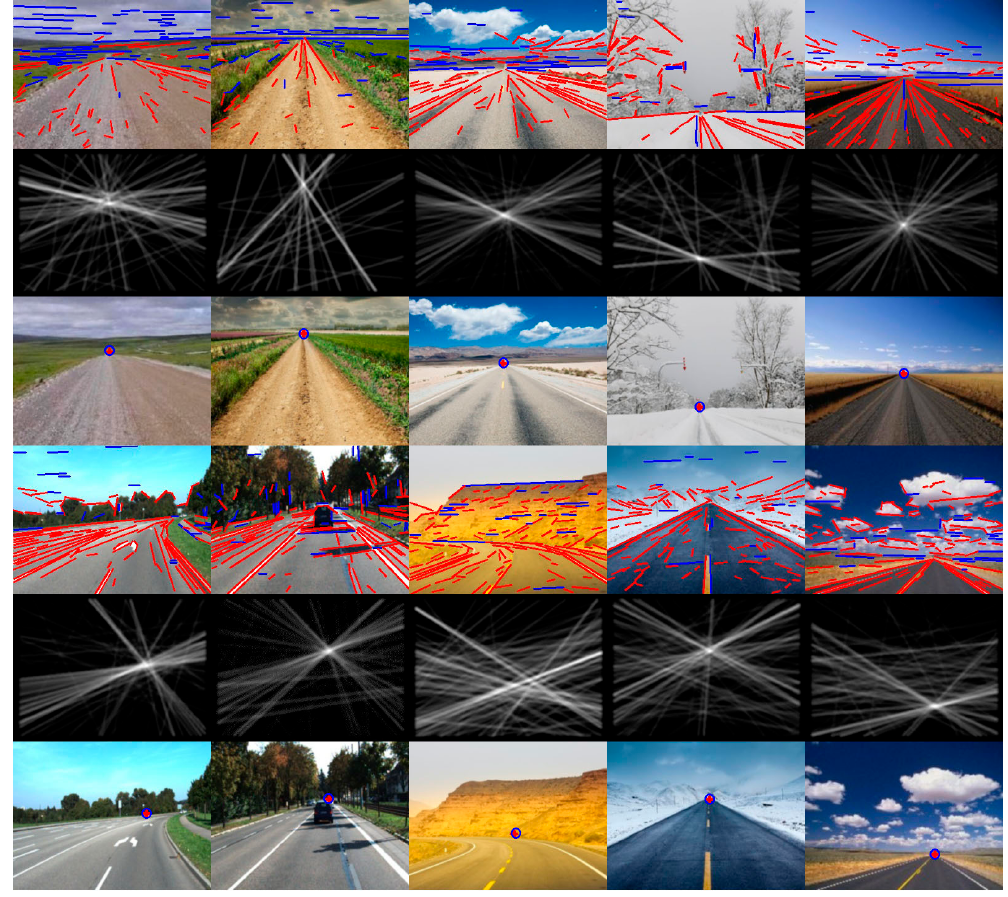
Figure 9. Vanishing point detection and road segmentation examples for different road types using the study’s proposed method. The first and fourth row images are the detected line segments. The second and fifth row images are the line space voting images. The third and sixth row images are the input images covered with the detected VPs.